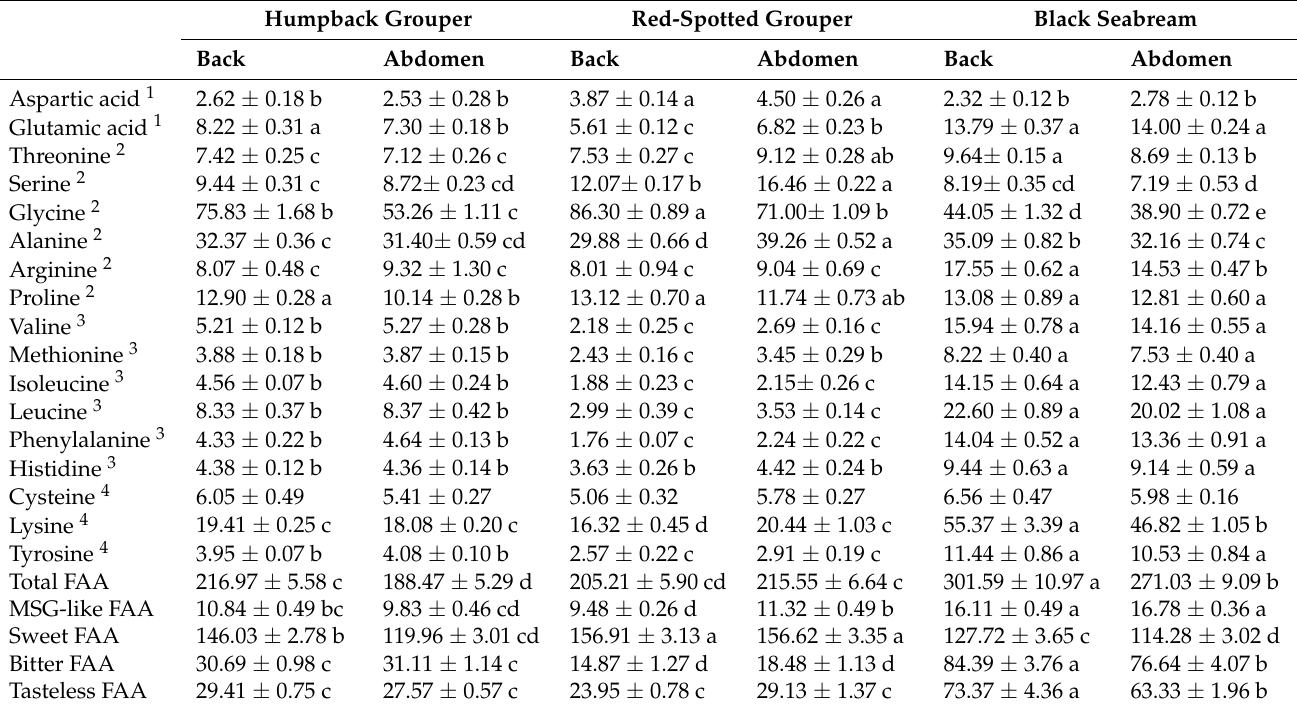
Table 3. The contents of free amino acids (FAAs) of back and abdominal muscles in three perciform fishes (mg/100 g of wet